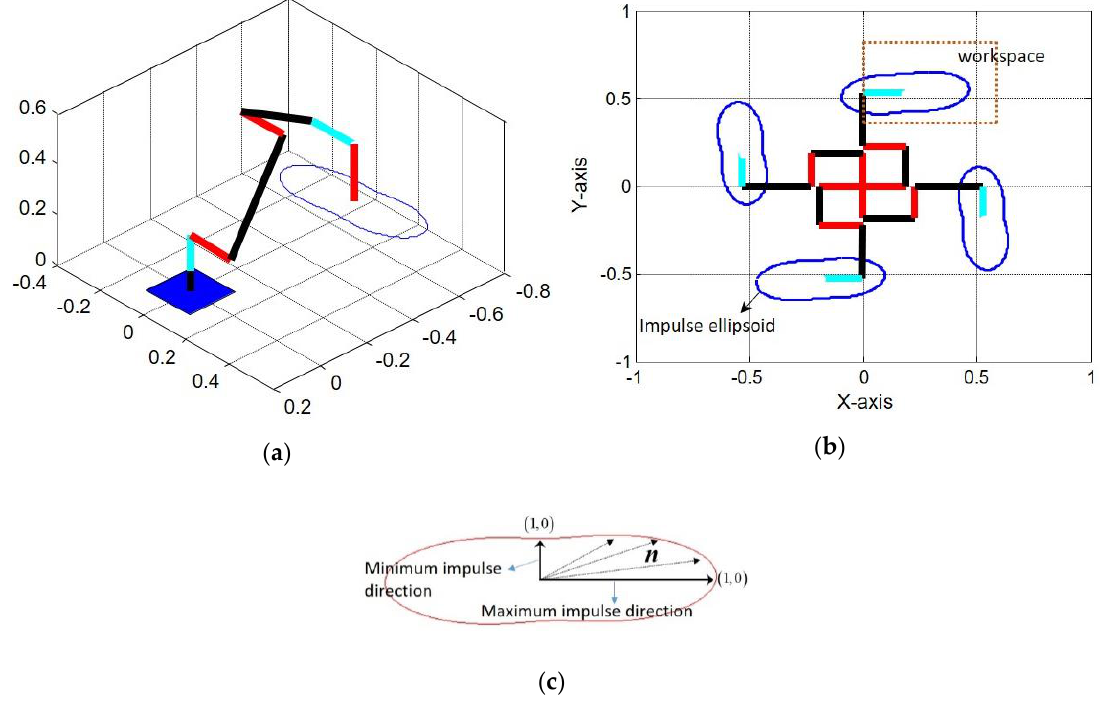
Figure 10. Impulse geometry: ( a ) normalized impulse ellipsoid for the Indy 7 robotics arm; ( b ) impulse ellipsoid for the four configurations; ( c ) maximum and minimum impulse direction.